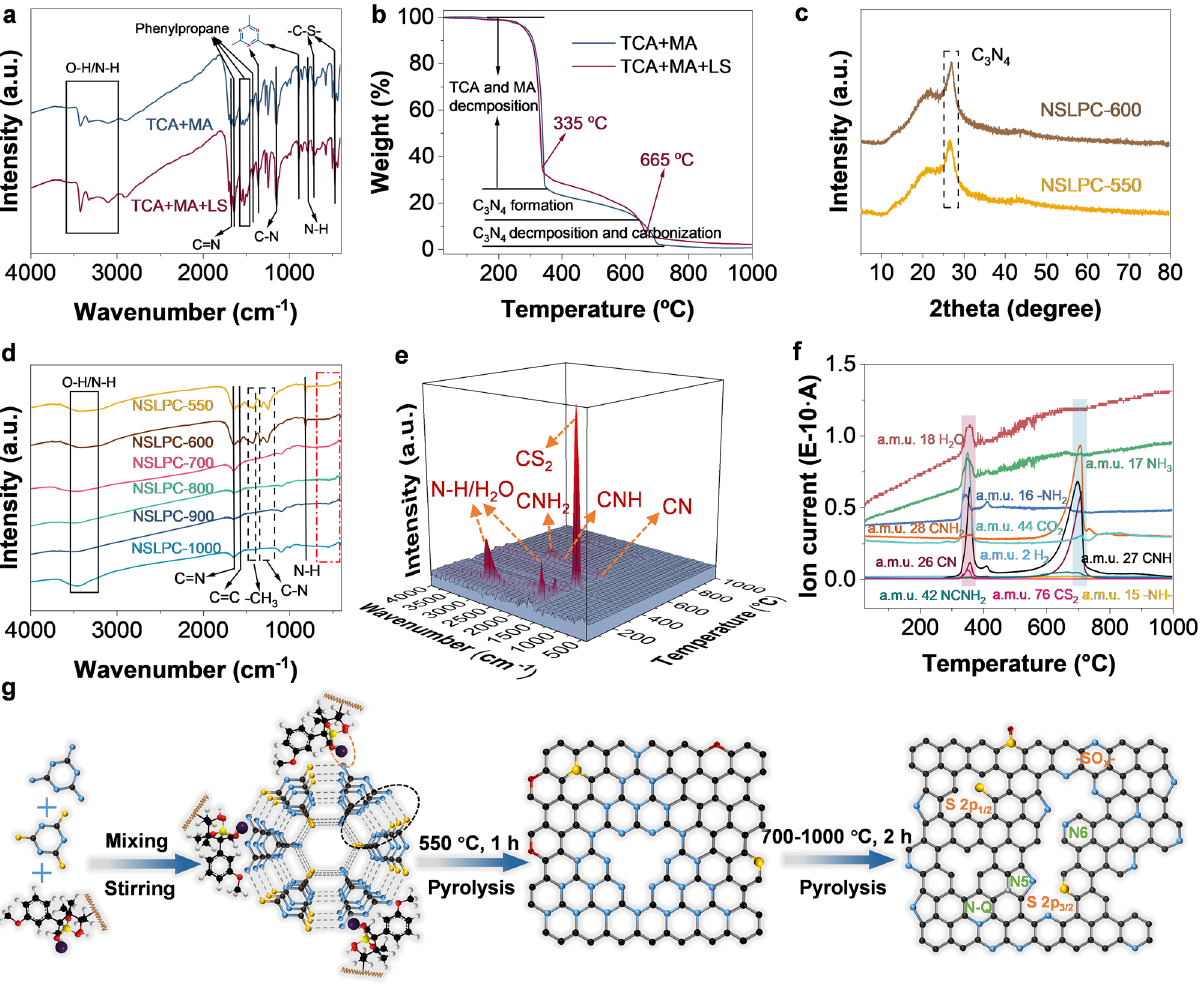
Fig. 3 a FTIR spectra of TCA + MA and TCA + MA + LS. b TGA curves of TCA + MA and TCA + MA + LS. c XRD patterns of NSLPC-550 and NSLPC-600. d FTIR spectra of NSLPC-550, NSLPC-600, NSLPC-700, NSLPC-800, NSLPC-900, NSLPC-1000. e TGA-FTIR spectra. f TGA-MS spectra of the TCA + MA + LS along with the carbonization temperature. g Pyrolysis reaction